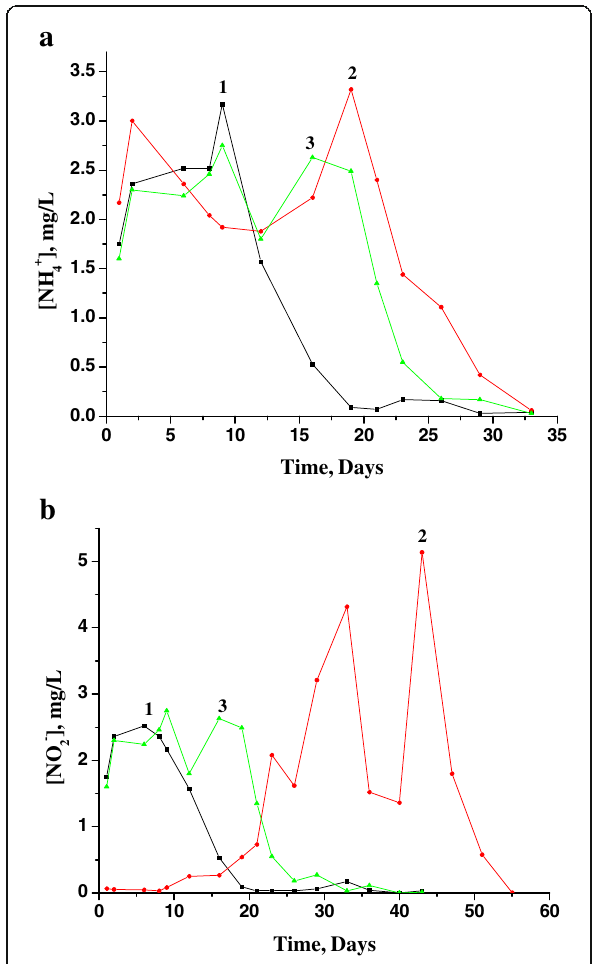
Fig. 2 Dynamics of ammonium ( a ) and nitrite ( b ) ion concentrations in the Nistru River. 1 — Reference sample. 2 — SAS-Ct . 3 — SAS-An +